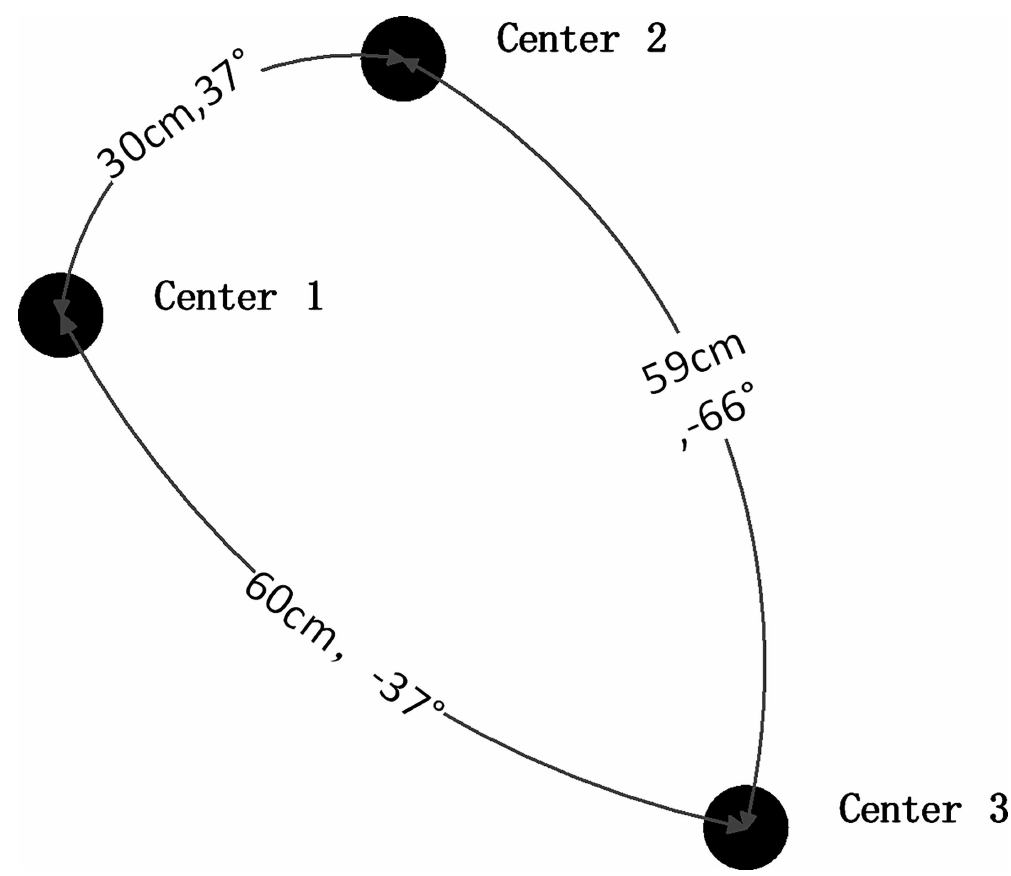
Fig 4. Multi-camera calibration board with known positions of